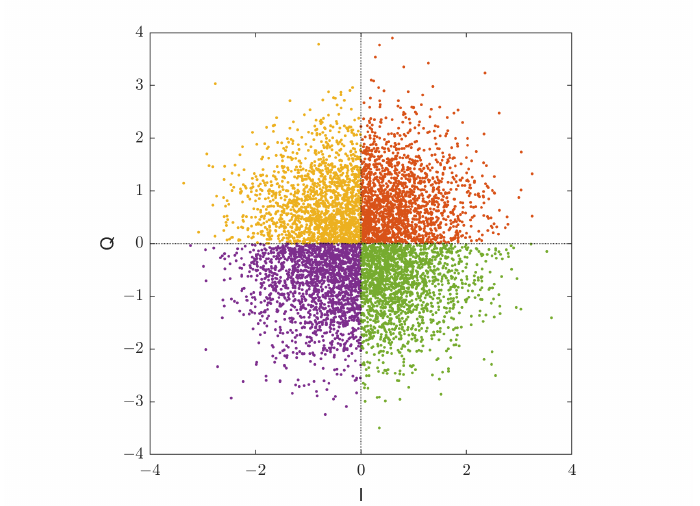
Figure 5. A collection of scattered constellation points of the proposed QPSK GDSS signal, with matching colours of QPSK DSSS in Figure